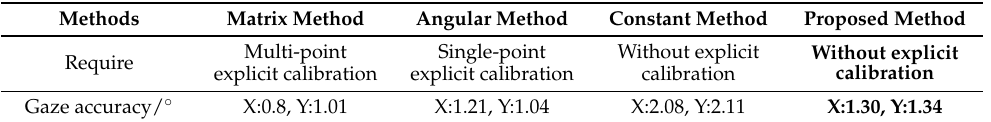
Table 7. Comparison of different